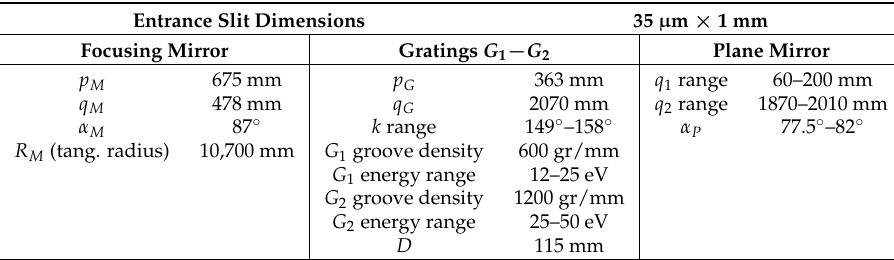
Table 1. Parameters of the